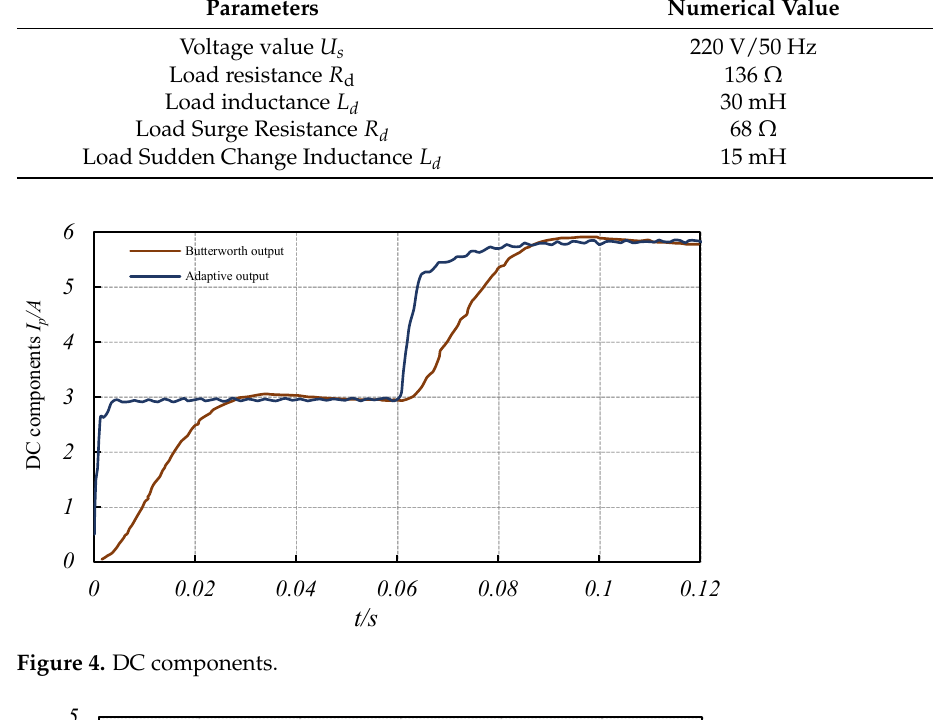
Figure 4. DC components.